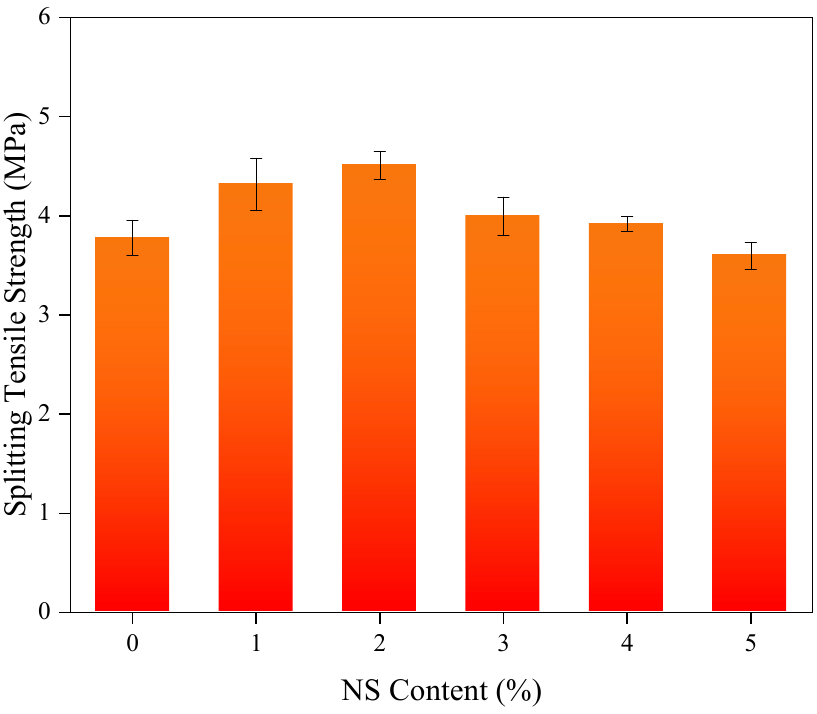
Figure 7. Splitting tensile strength of concrete with NS.